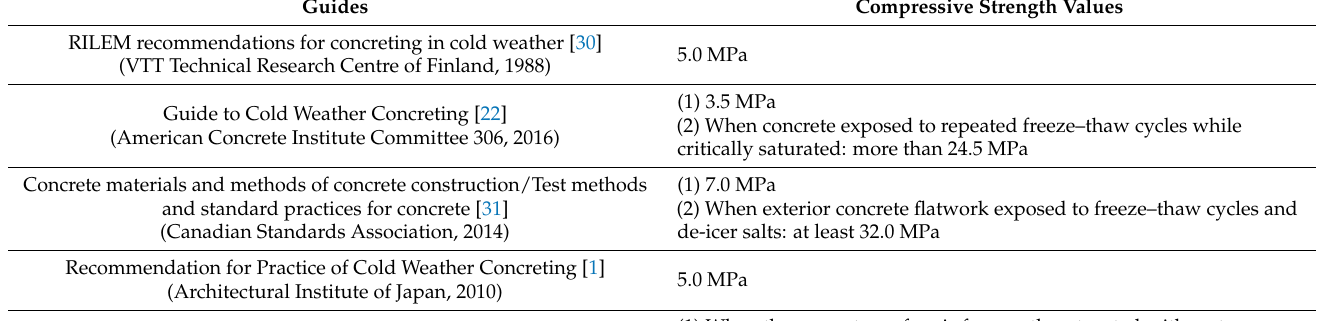
Table 1. Regulation content of minimum required compressive strength of various countries.